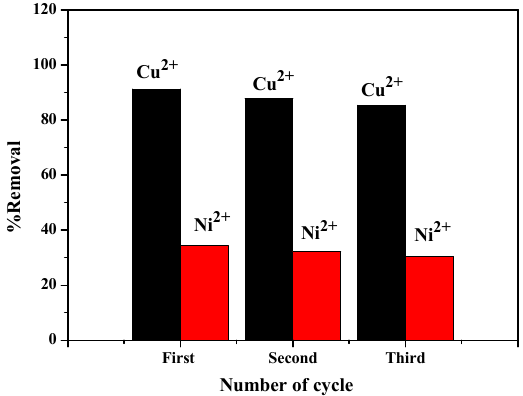
/ FA composite for adsorption of heavy metal Figure 10. Recyclability of ZIF-8/FA composite for adsorption of heavy metal ions. Figure 10. Recyclability of ZIF-8